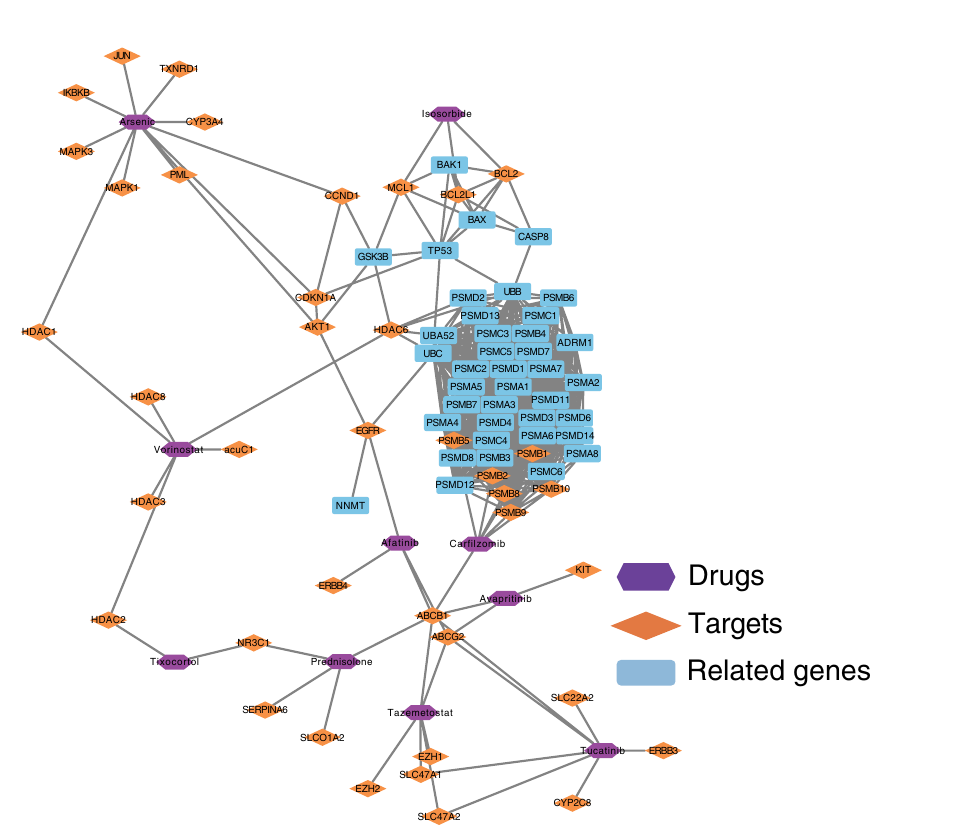
Table 1. Prediction of drug target and distance information by top10 (FDR < 0.1).